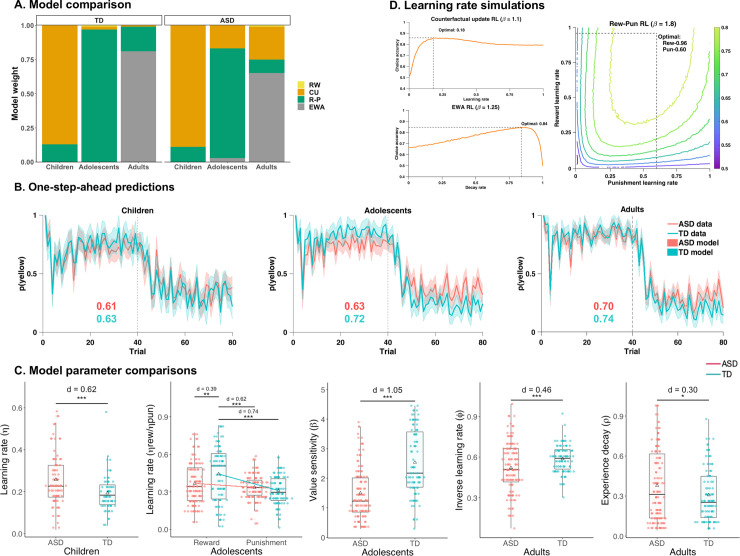
Model comparisons, validations, and parameters.(A) Evidence (model weights) for models within each diagnostic and age group. Very similar patterns are observed for TD and ASD groups; winning models for children, adolescents, and adults are the CU, R-P, and EWA-DL, respectively. (B) One-step-ahead posterior predictions for each age and diagnostic group according to winning models. Colored lines indicate diagnostic-group-averaged trial-by-trial task behavior; shaded areas indicate 95% HDI of the one-step-ahead simulation using the entire posterior distribution. Compare with actual task data in Fig 2A. Posterior predictive accuracies are also indicated on each plot (ASD: red; TD: blue). (C) Model parameter comparisons. Within each winning model and thus age group, parameter estimates were compared between diagnostic groups: (1) ASD children showed a significantly higher learning rate (η) than TD children, in which simulations showed the optimal learning rate to be 0.18; (2) ASD adolescents showed a significantly lower reward learning rate than TD adolescents, but no difference between punishment learning rates was observed; (3) ASD adults showed significantly lower φ than TD adults, the optimal value was shown to be 0.85 in simulations, and ASD adults also showed significantly greater experience decay (ρ) than TD adults, suggesting great perseveration. (D) Learning rate simulations showing optimal learning rates for each model (Counterfactual update, compare to Fig 3C Children; Rew-Pun, compare to Fig 3C Adolescents—Learning rate; EWA, Experience-weighted attraction-dynamic learning rate, compare to Fig 3C Adults—Inverse learning rate). ***p < .001, **p < .01, *p < .05; Δ indicates group mean (see S1 Data). ASD, autism spectrum disorder; CU, counterfactual update; d, Cohen’s d model; EWA-DL, experience-weighted attraction–dynamic learning rate model; HDI, highest density interval; R-P, reward-punishment model; Rew-Pun, reward-punishment; RL, reinforcement learning; RW, Rescorla-Wagner; TD, typical development.